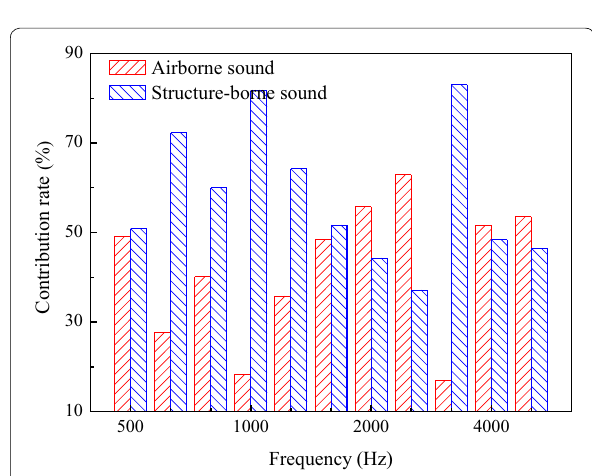
Figure 27 Contribution rate of the airborne sound to the interior